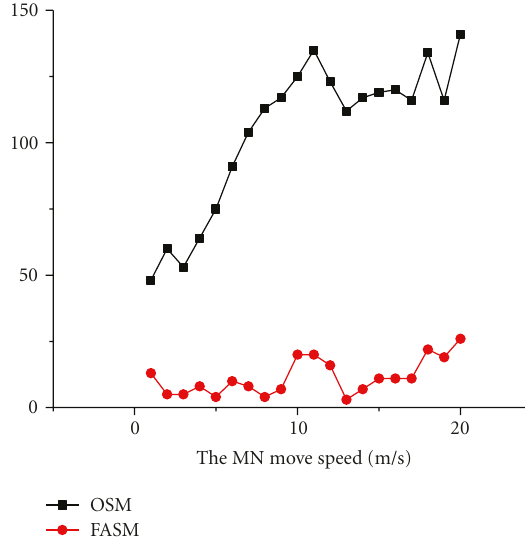
Figure 11: Packet loss versus Pr.